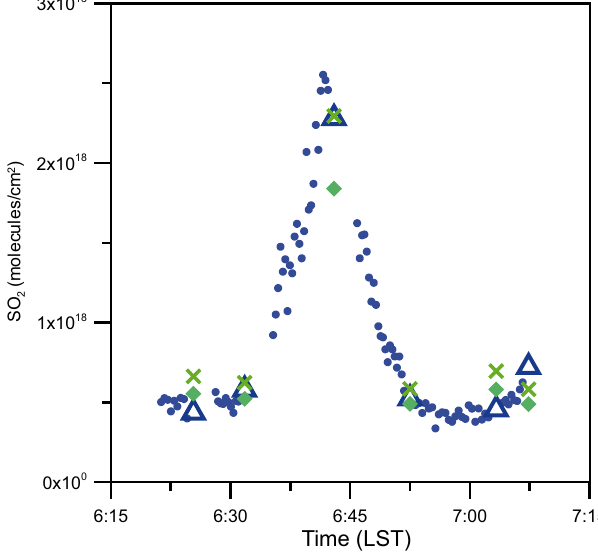
Fig. 7. Slant columns of SO 2 retrieved from lunar absorption spectra (blue) plotted together with SO 2 from thermal emission spectra at 0.5 cm − 1 (green). The diamonds are results when a plume tem- perature is assumed to be 272K and the crosses are after fitting the SO 2 columns to the lunar absorption value, giving a plume temper- ature of